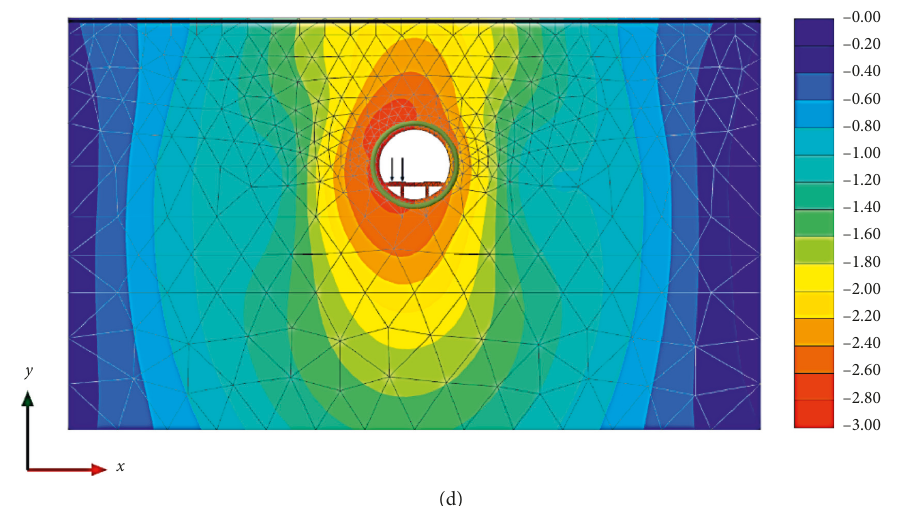
Figure 15: Vertical displacement contour plots of the four scenarios. (a) Scenario I. (b) Scenario II. (c) Scenario III. (d) Scenario IV.